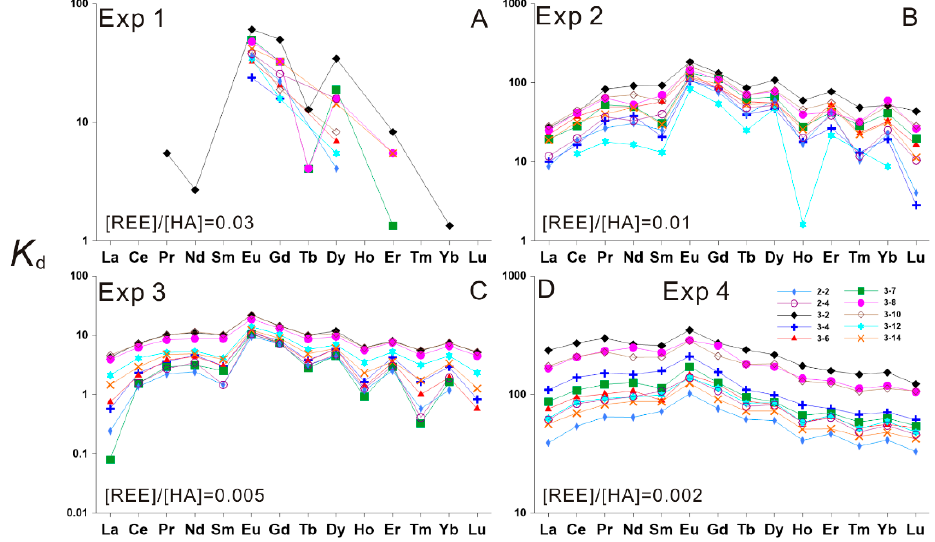
Figure 3. REE distribution pattern of K d obtained at 50 °C and various [REE]/[HA] ratios. ( A ), Experiment 1, performed at a [REE]/[HA] concentration ratio of 0.03 ([REE]/[HA] = 0.03); ( B ), Experiment 2, performed at [REE]/[HA] = 0.01; ( C ), Experiment 3, performed at [REE]/[HA] = 0.005; ( D ), Experiment 4, performed at [REE]/[HA] = 0.002 .